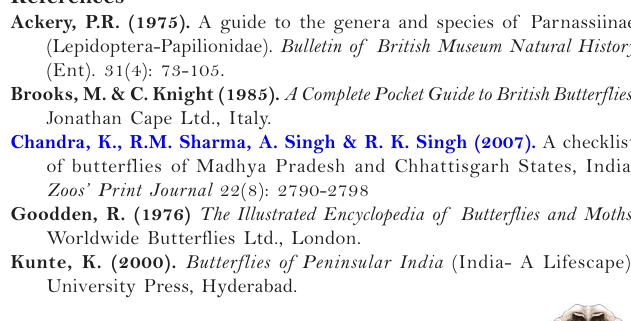
include Evening Browns ( Melanitis ), Grass Blues ( Zizula , Zizina , ( Euchrysops cnejus )